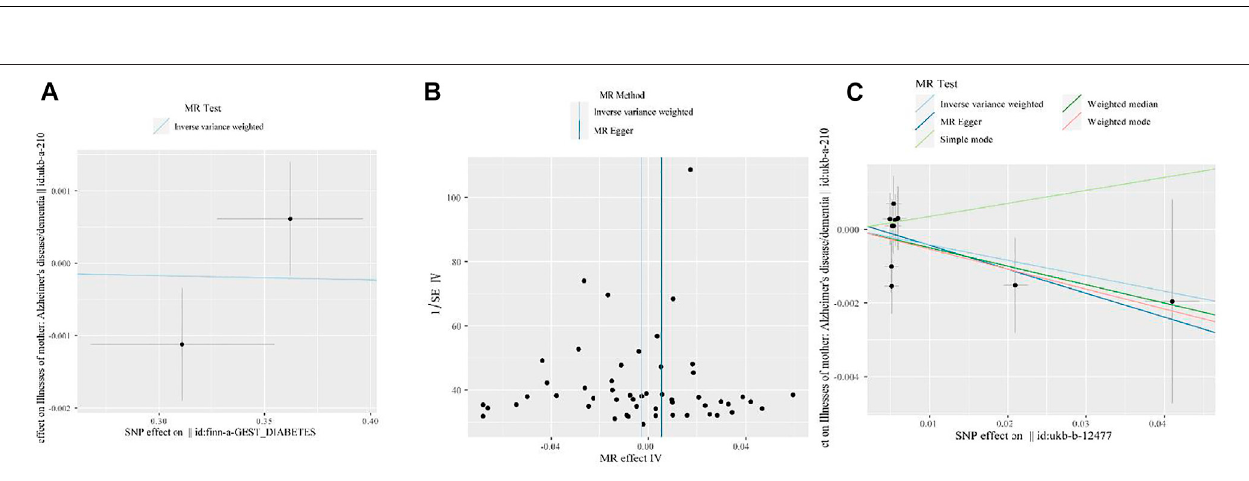
FIGURE 3 | Visualization of the MR analysis results for GDM, high BMI, HD, and maternal dementia. (A) Scatter plot for MR analyses of the causal association betweenGDM andmaternaldementiamainly via IVWmethod.Theslopeofthebluelineinthemiddle indicates theMReffect using theIVWestimation. (B) Funnelplotof the causal association between high BMI and maternal dementia. We performed analyses by the classical IVW and MR-Egger tests. The two vertical lines (from left to right) in the middle represent the MR effect using IVW method and MR Egger methods, respectively. (C) Scatter plot of the MR effect of HD on maternal dementia determined using multiple methods. Analyses include the IVW and MR-Egger methods, the simple mode, and the weighted median and weighted mode. The slope of each line in the middle indicates the MR effect for each